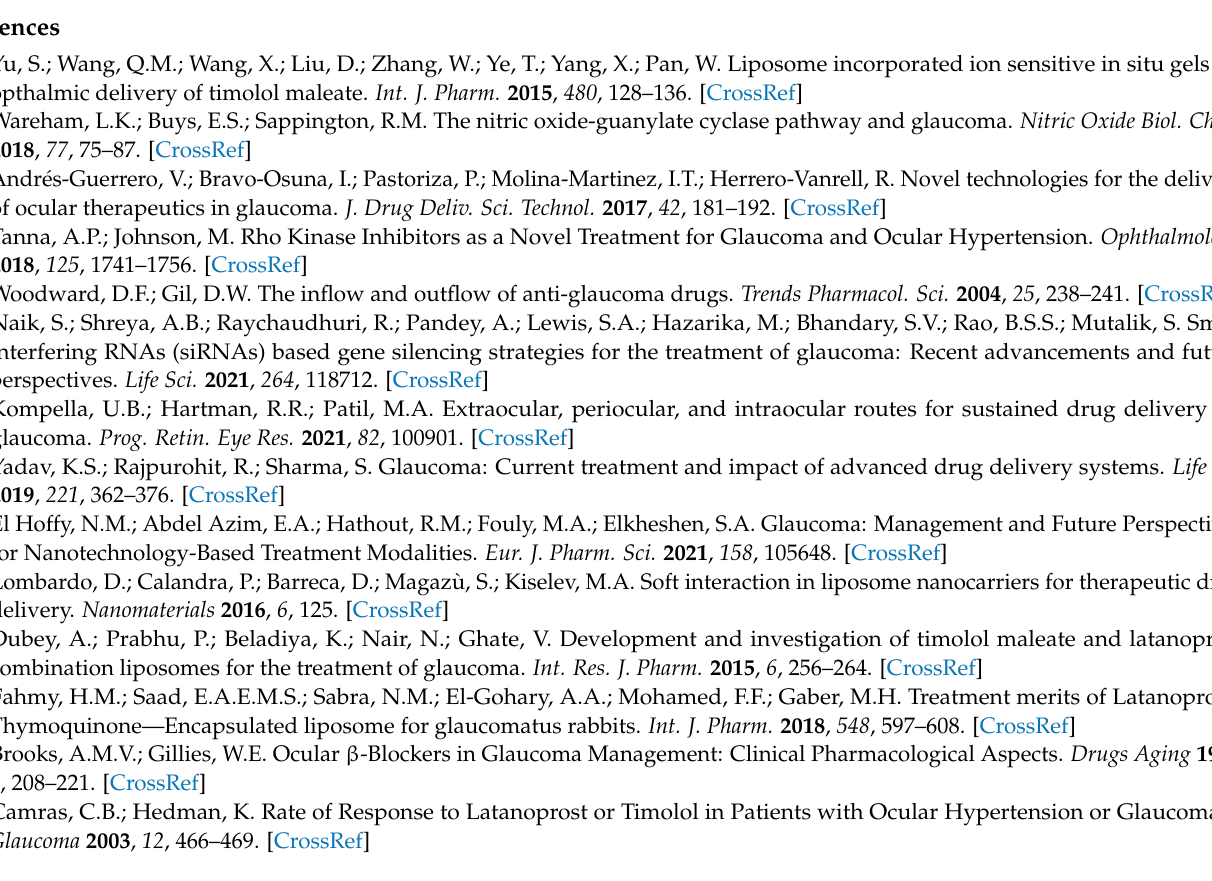
Mean ± SD; Table S2: Mean values of HP β CD concentrations and acetazolamide (Acz) concentrations dissolved in the presence of Acz/HP β CD, Acz/HP β CD/Ch, or Acz/HP β CD/Chems. These mean values (St) and their SDs are plotted in Figure 1a. Bold values represent S0. Log (St-S0) mean values and their SDs were also tabulated for each formulation, and they are plotted in Figure